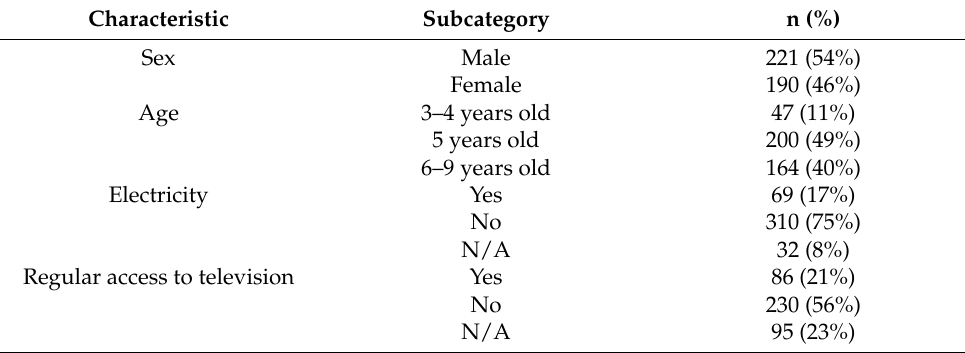
Table 1. Demographics of